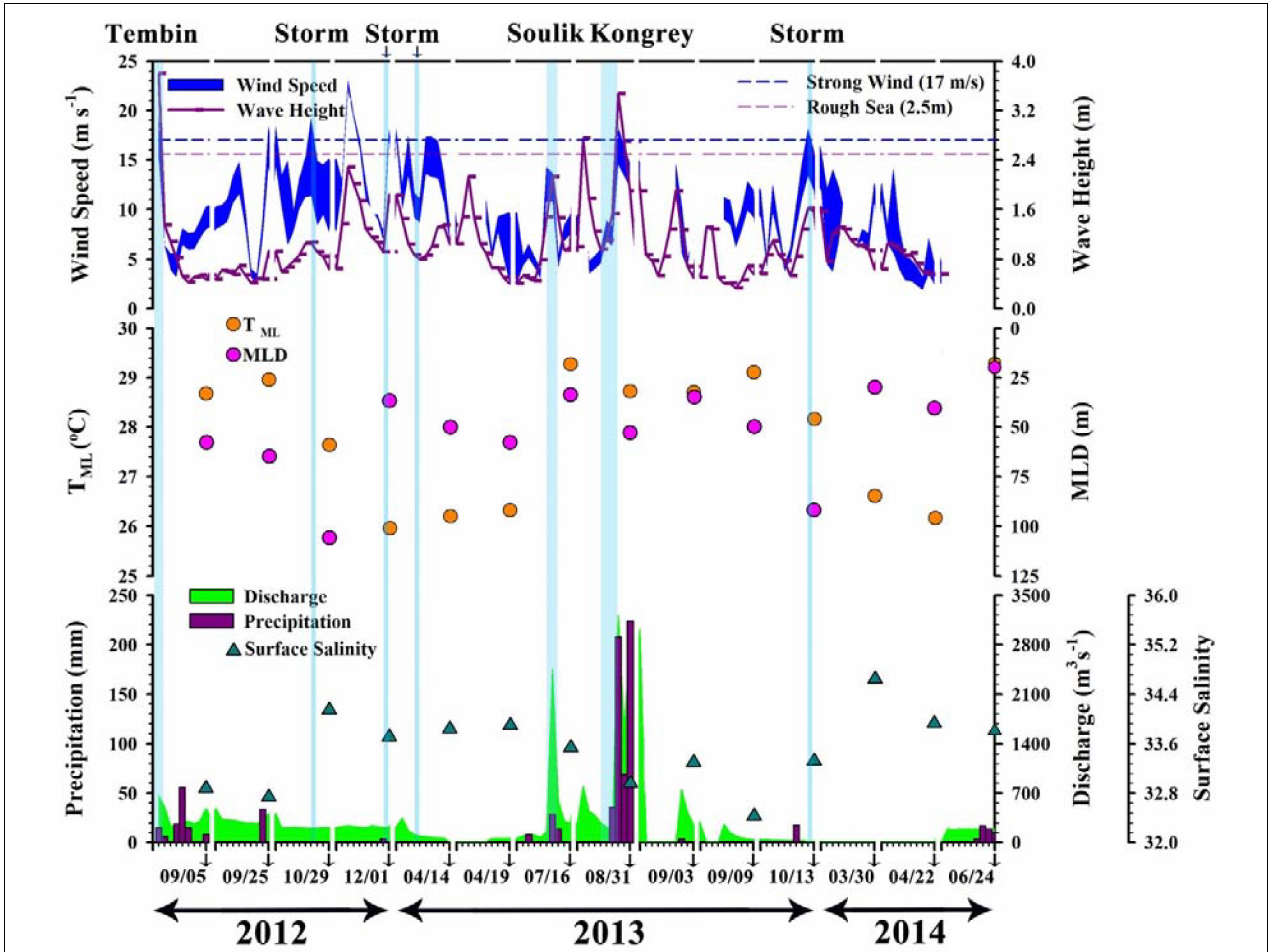
FIGURE 2 | Evolution of wind speed and wave height (top), precipitation and river discharge (bottom) over the 8 days preceding each field survey. Hydrographic variables measured on the survey dates ( X axis labels) are represented by orange (T ML ), pink (MLD) and green symbols (surface salinity). Vertical bars indicate the periods of influence of typhoons and storms (light blue